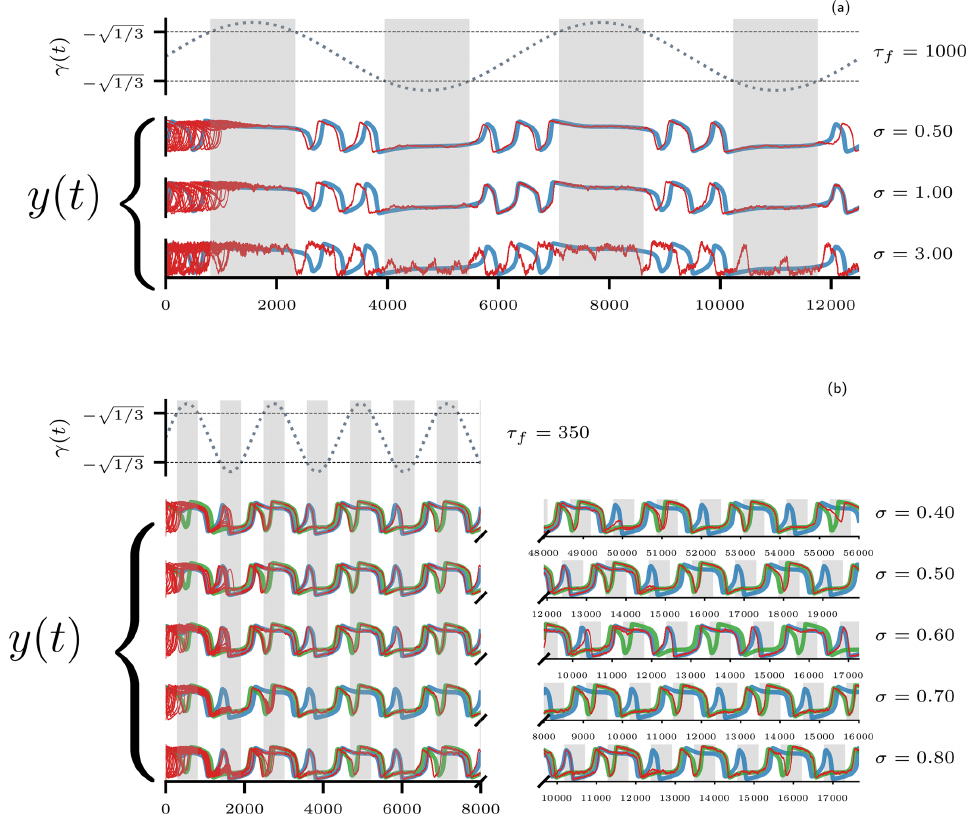
Figure 11. Random attractor of the periodically and stochastically forced FHN model governed by Eq. (26). (a) Results for slow periodic forcing with period τ f = 1000. The top graph shows the periodic forcing, with non-oscillatory intervals marked by gray shading. The next three graphs show the fast y component of the approximate random attractors, as per Eq. (26b); the noise variance σ increases from top to bottom. Each random attractor is approximated by integrating 20 trajectories (solid red) with different initial conditions over time and using the same Wiener process as their common stochastic forcing; the corresponding deterministic PBA is shown in blue. The random attractors and the PBA are very similar for small noise variances, but they differ more and more as the noise variance increases. (b) Results for faster periodic forcing with period τ f = 350. The forcing is only shown for the first 8000 time units, with non-oscillatory intervals again shaded gray. The left part of panel (b) shows five approximate random attractors, computed as in panel (a) , on a common time axis. The panel’s right- hand side shows their continuations on individual time axes in order to display the moment when full noise-induced synchronization of the trajectories takes place. Prior to this point, the random attractor is split into two branches, which closely follow the PBA of the deterministic system (blue and green). For σ = 0 . 7, the synchronization already takes place during the first 8000 time